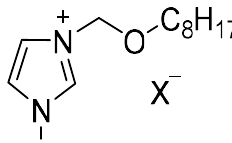
Figure 1. General Structure of New ILs.